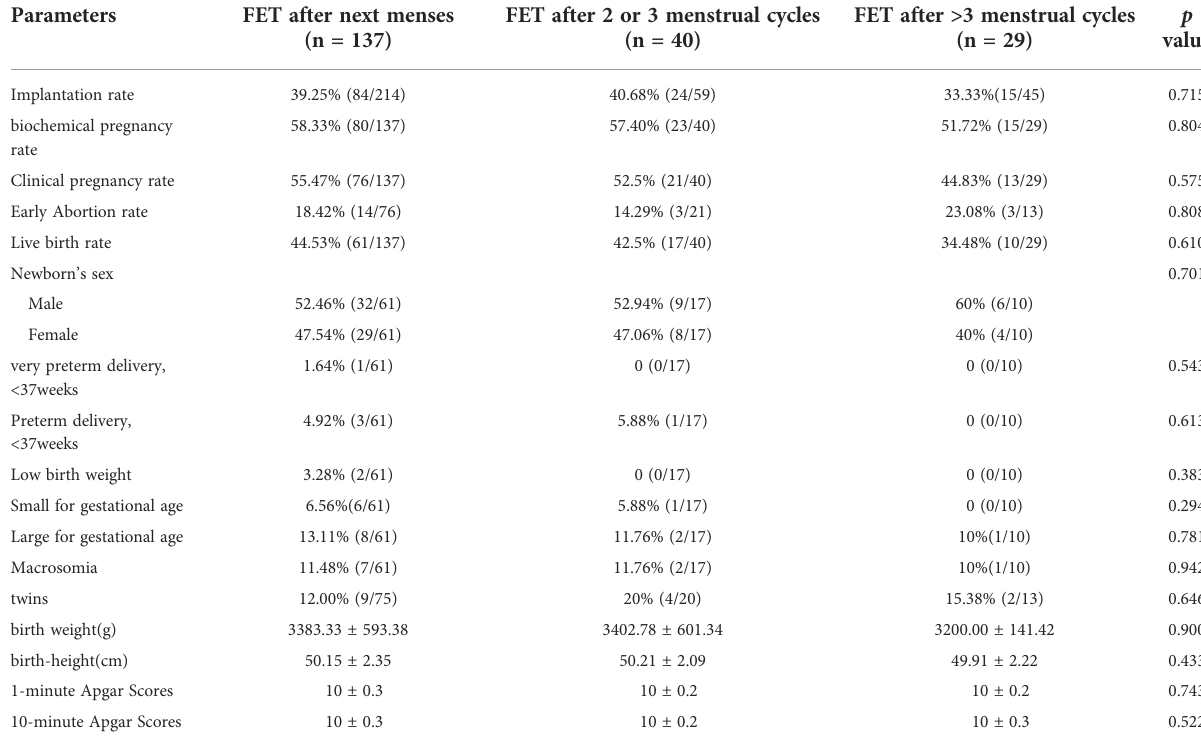
TABLE 3 Outcomes analysis of Subgroup.